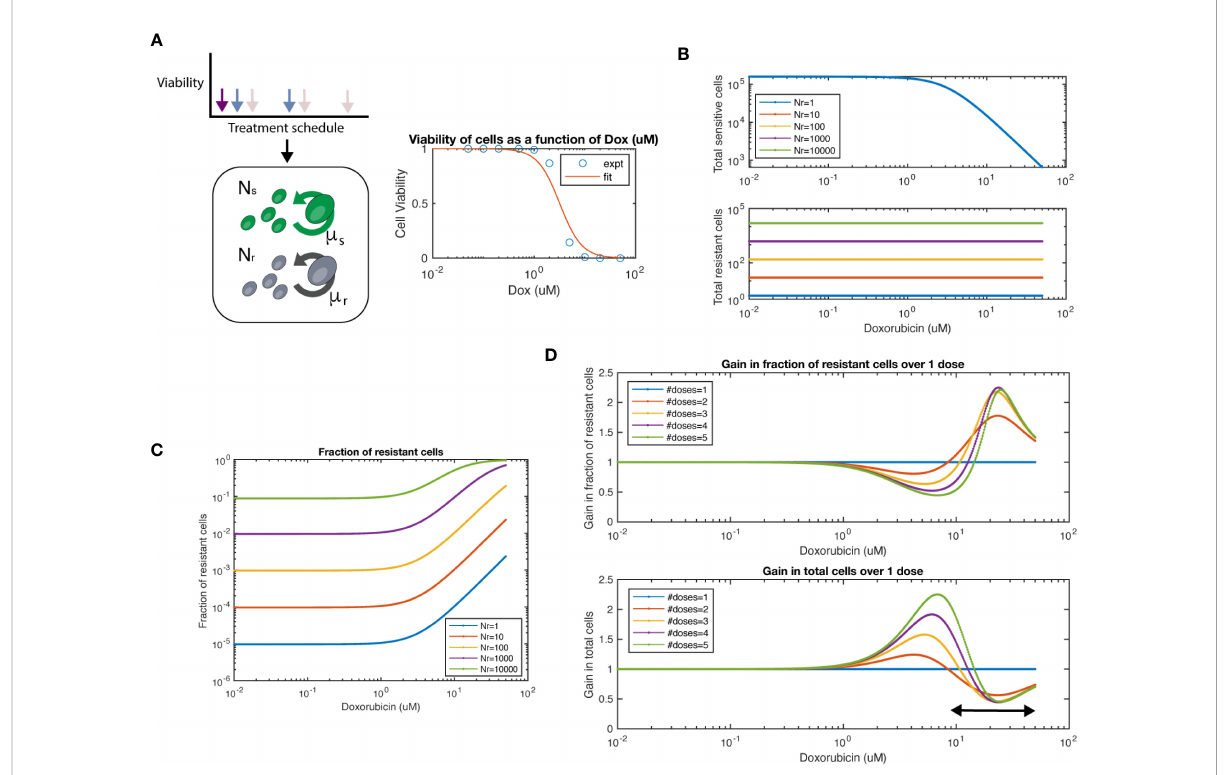
FIGURE 4 Mathematical model of chemosensitive and chemoresistant populations. (A) (left) Schematic of the underlying system modeled, whereby resistant (Nr) and sensitive (Ns) cell populations grow exponentially, and are then subject to chemotherapy regimens of varying frequency and dosage. (right) Viability of chemosensitive cells in response to doxorubicin. Data was fi t to a Hill function with hill coef fi cient = 2, and EC50 = 3.2 m M. (B) Total sensitive cells and total resistant cells at the end of interval as a function of starting dosage. Colors indicate varied initial conditions of N r = 10 0 , 10 1 , 10 2 , 10 3 , 10 4 , where N s = 5x10 4 . (C) Fraction of resistant cells as a function of starting dosage for varied initial conditions. (D) For a 1:1 mixture of Ns to Nr, number of doses is varied. The fraction resistant, total cell population are plotted on the top row. The ratio of a particular number of doses to 1 dose is termed the “ Gain ” , both for fraction resistant and total cell population. The arrow at bottom panel shows the chemotherapy dose range where multiple doses show lower number of total cells over single